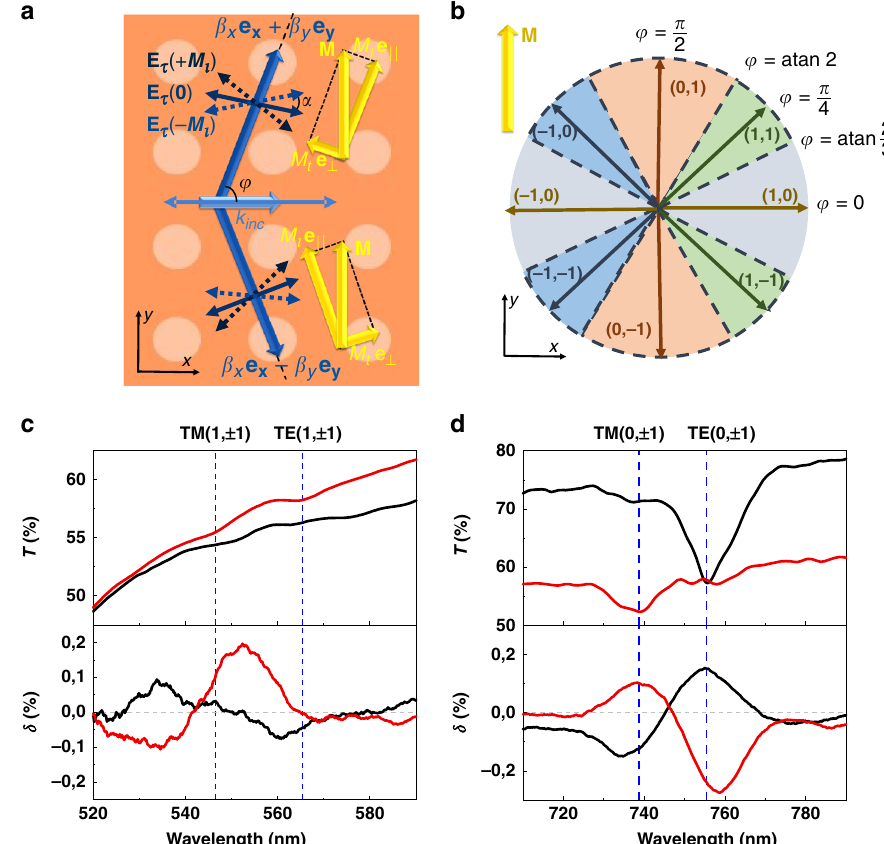
Fig. 4 Transverse magnetophotonic intensity effect (TMPIE) in magnetic metasurface. a Schematic representation of the physical mechanism of the effect for the guided modes propagating outside the incidence plane (shown for the TE-modes excited by p-polarized light). b Schematic representation of ( l x , l y ) mode propagation direction described by angle φ , arrows show φ ( θ = 0) and sectors of corresponding colors show all possible range of φ for the mode. Simultaneously excited modes are shown in similar color. c , d Wavelength spectra of TMPIE and transmittance for p- (black color) and s- (red color) polarized incident light shown in different spactral regions at the fi xed angles of incidence: 44 deg for c and 15 deg for d